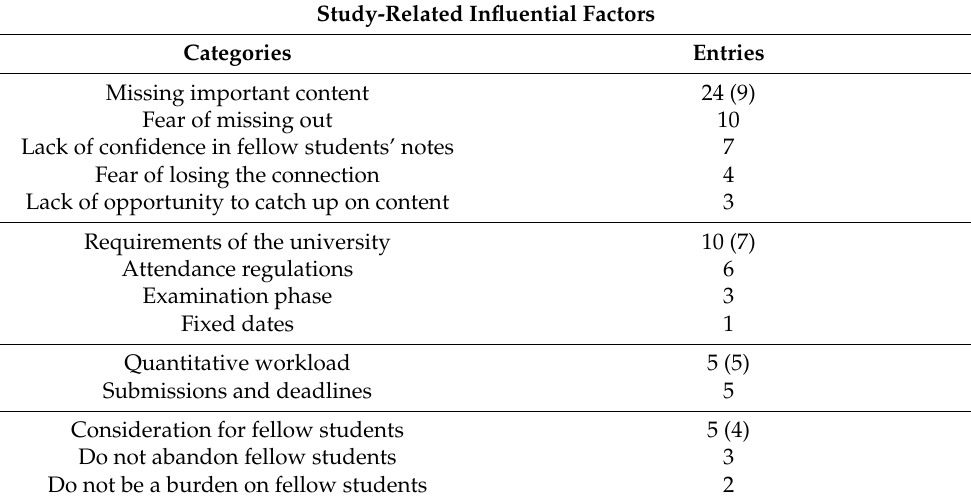
Table 7. Results of the open-ended questions on the reasons for presenteeism (study-related influential factors).